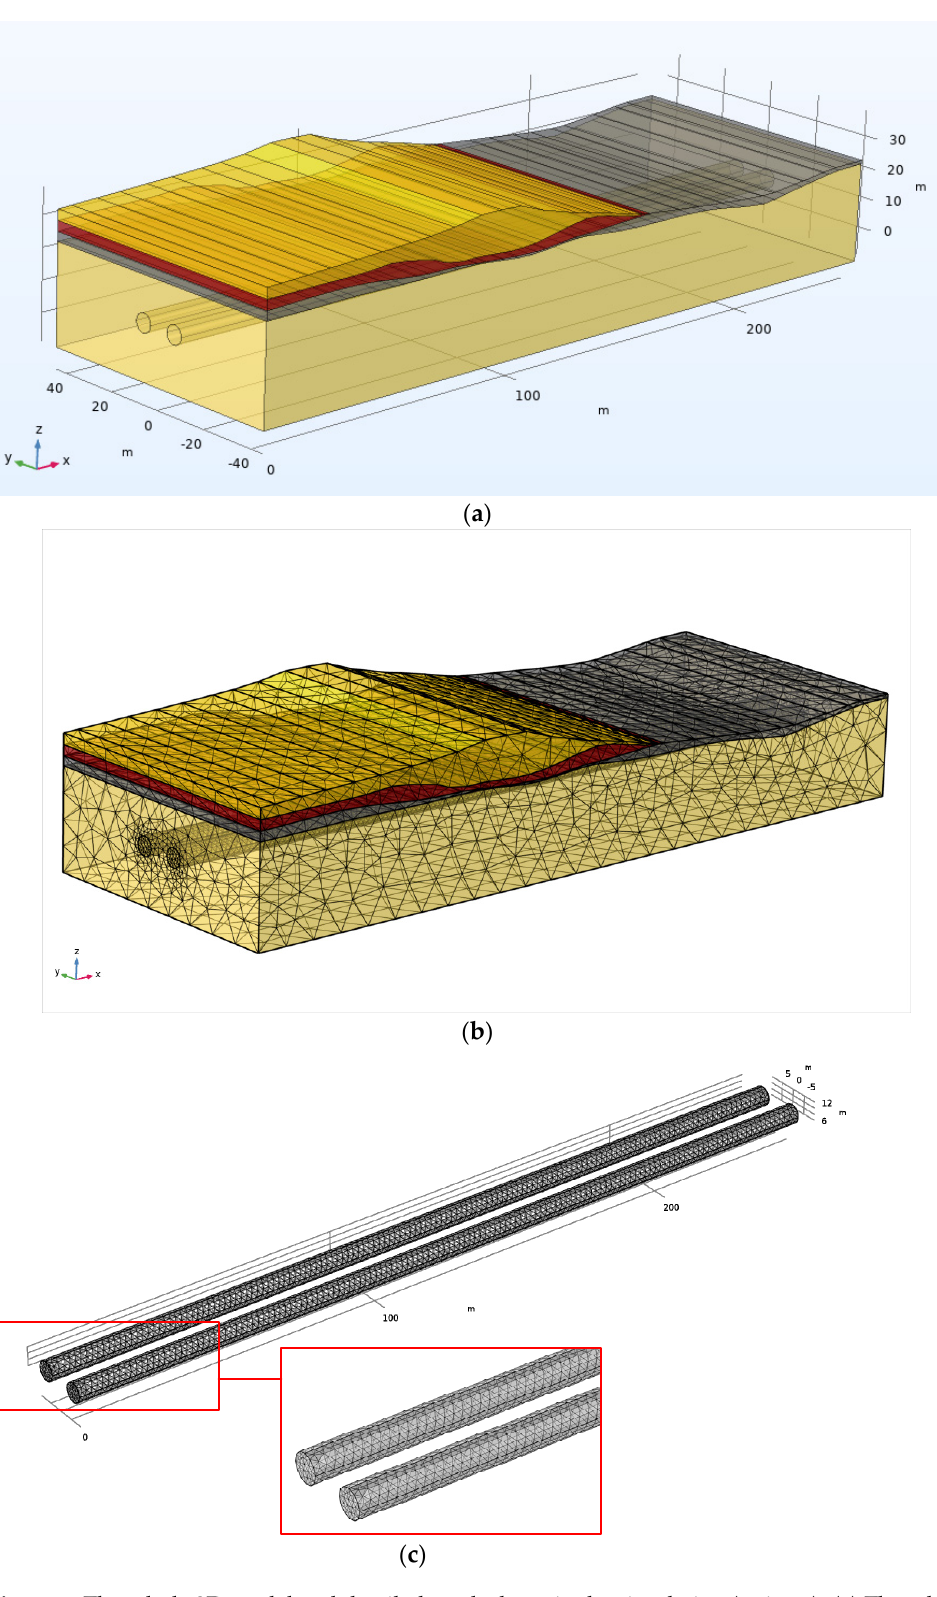
Figure 3. The whole 3D model and detailed mesh shape in the simulation (unit: m). ( a ) The whole 3D model. ( b ) The mesh of the 3D model. ( c ) The mesh of the twin tunnels. Table 1. The main parameters of the strata.